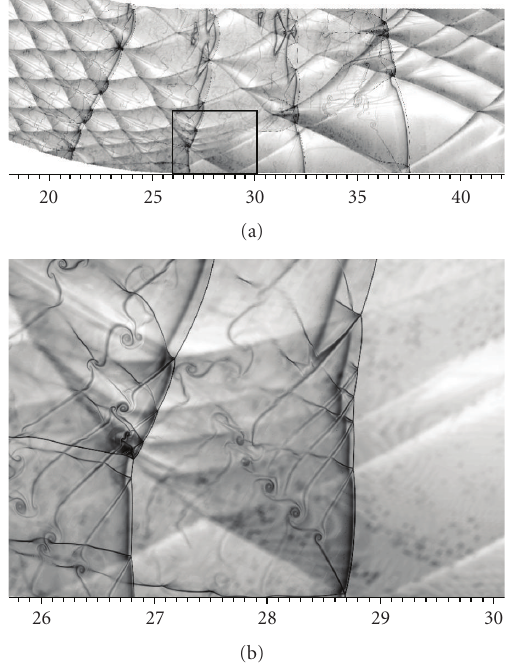
Figure 26: (a)Cellular structure immediately after the bend (shown rotated) for ϕ = 30 ◦ , (b) triple point quenching and failure as SMR at 140 μ s and 150 μ s simulated physical time.